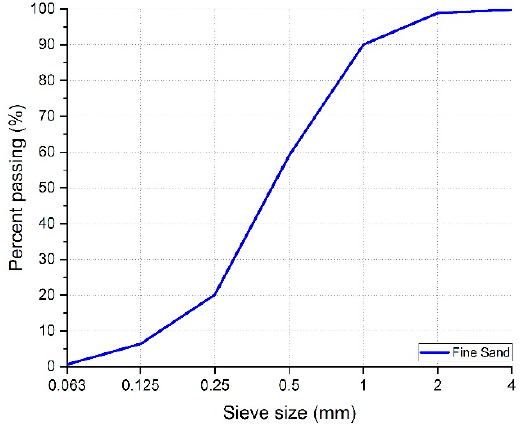
Figure 2. Particle size distribution of the fine aggregates used in this study.